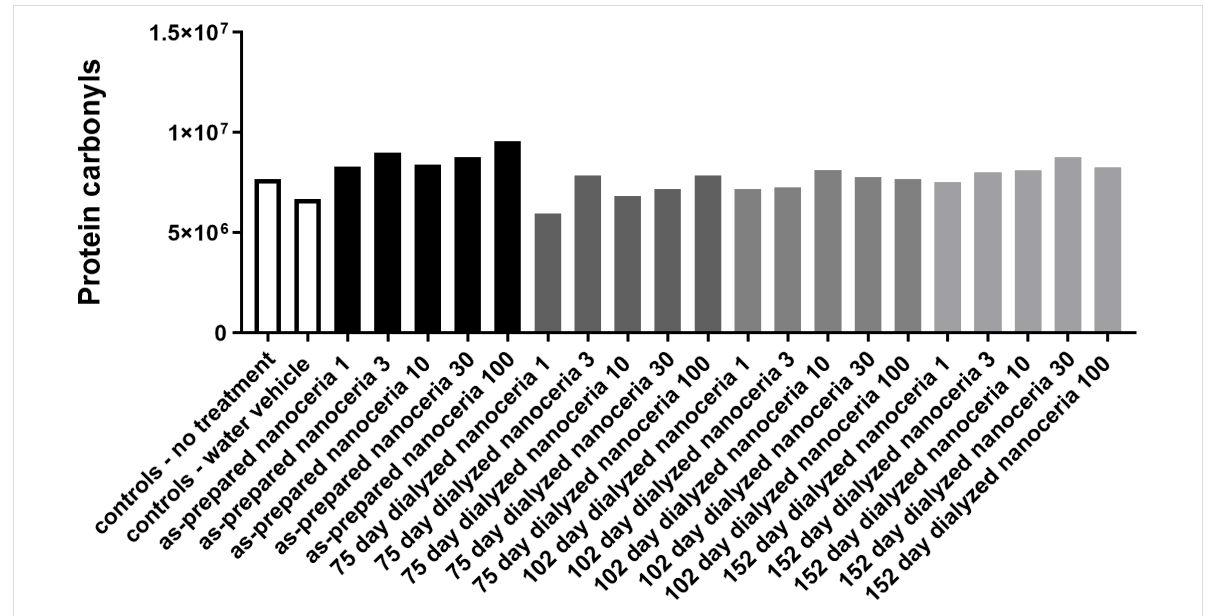
Figure 12: As-prepared and partially dissolved nanoceria altered cell protein carbonyl production. RAW 264.7 cell protein carbonyl production in response to the as-prepared and partially dissolved nanoceria. X -axis numbers refer to the nanoceria concentration in μ g/mL. Results are the mean of two determinations from one experiment.